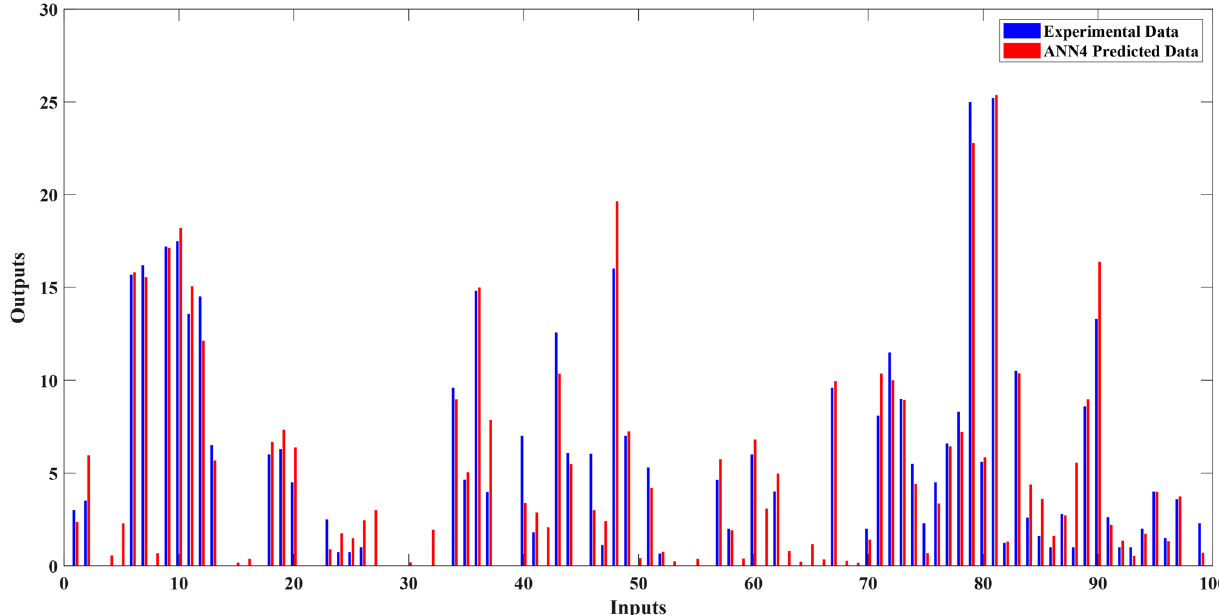
Fig. 29 The performance evaluation of Model No.4 (ANN 3) based on the predicted and experimental